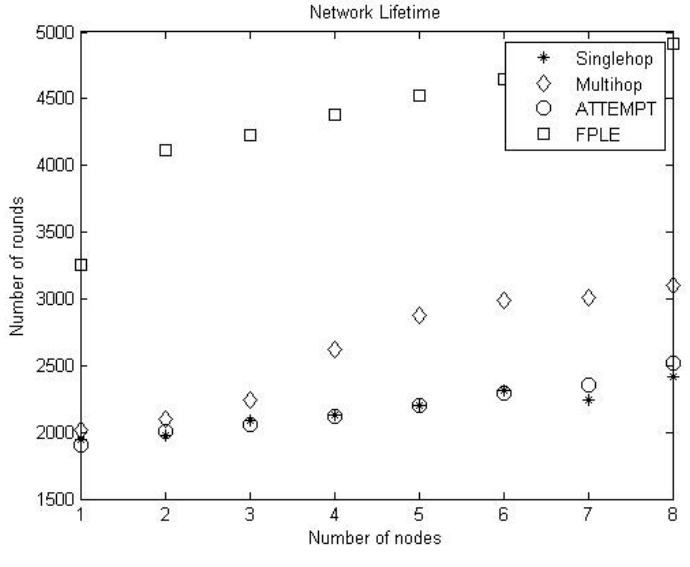
Figure 5. Network Figure 5. Network lifetime.